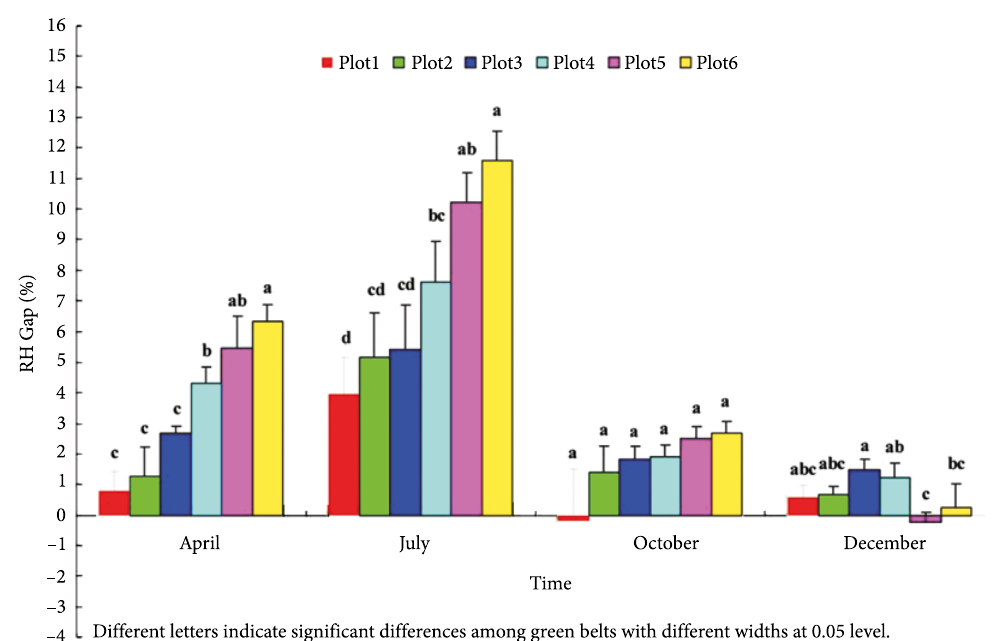
Fig. 6. The 3-day average of air RH in the green